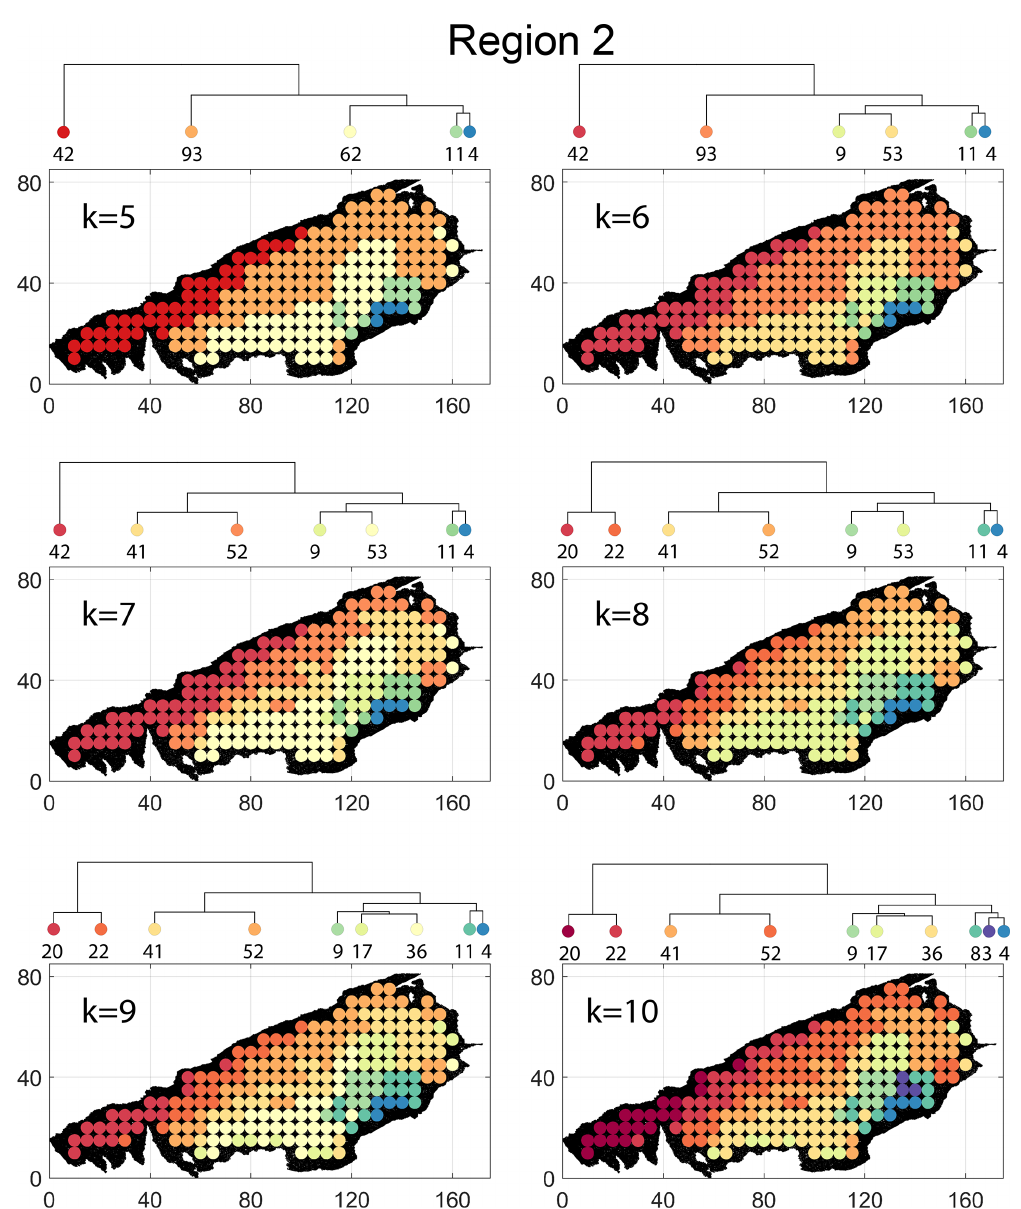
Figure B5. Variation in cluster boundaries for “ k ” clusters in Region 2 using fingerprint distance.